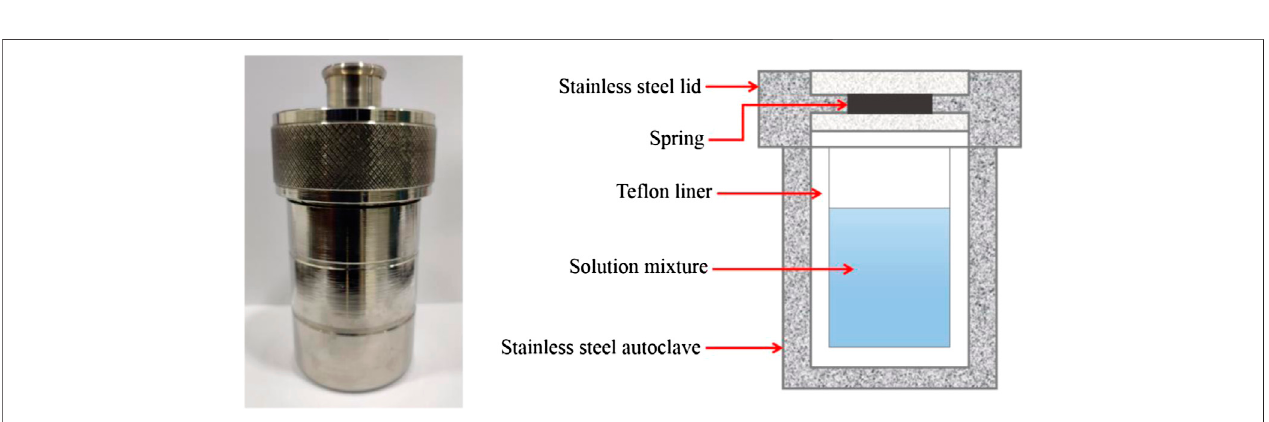
FIGURE 8 | Schematic representation of the Te fl on-lined stainless-steel hydrothermal autoclave.